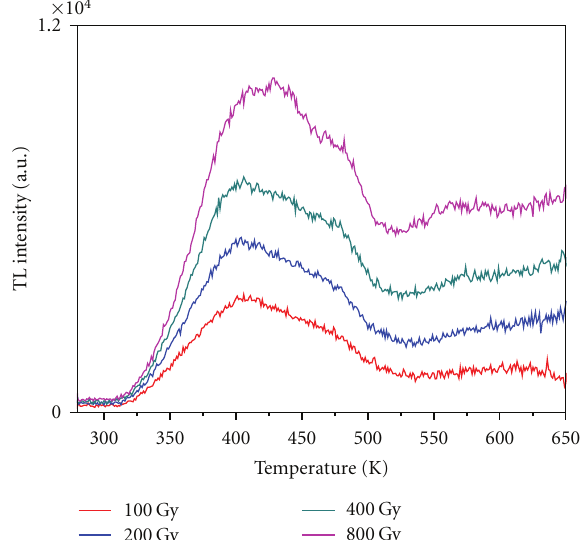
Figure 15: TL glow curves of MG 3 -Fe at di ff erent doses in the interval 100–800 Gy.